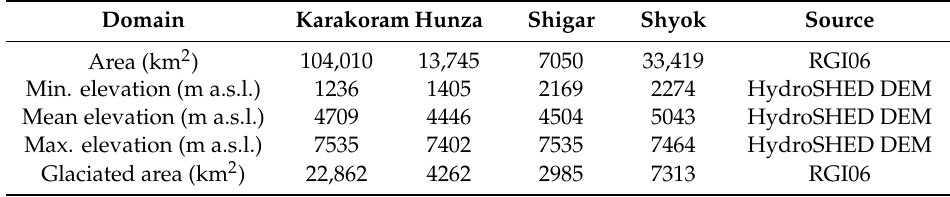
Table 1. Topographic characteristics of the Karakoram region and its river subbasin.